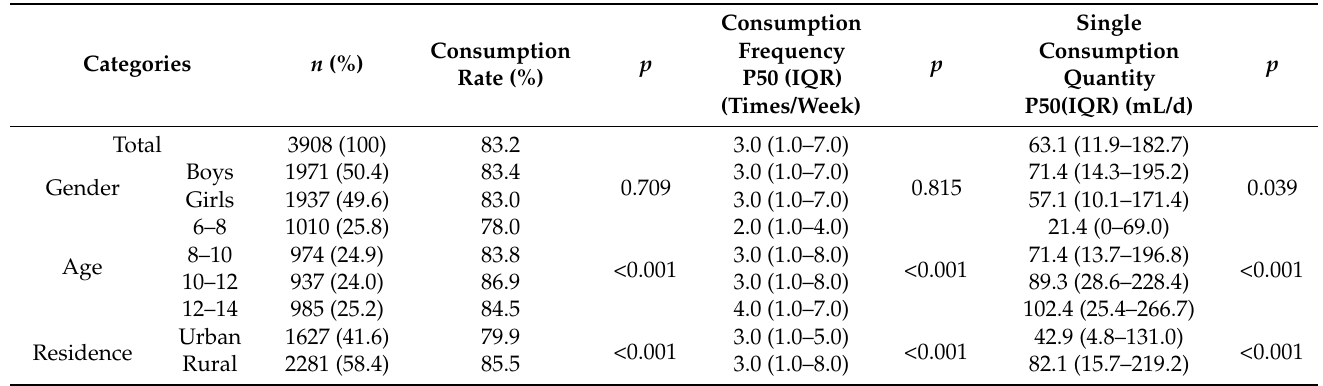
Table 3. Consumption rate, frequency and single consumption quantity among students.